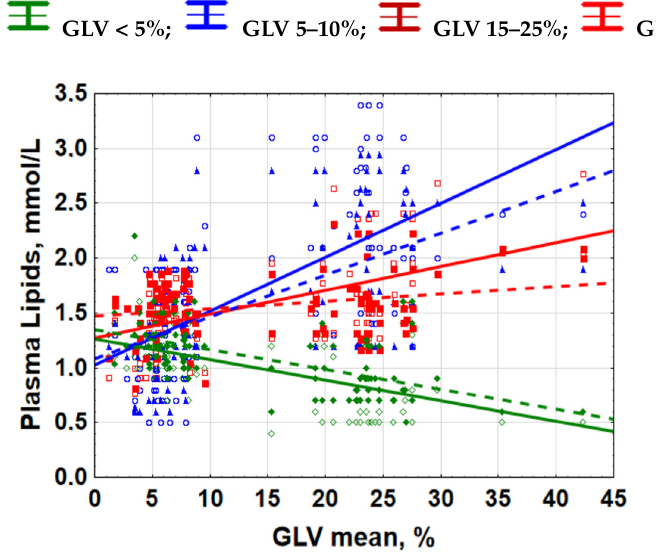
LDL-C MEGs increased further for RGC damage above 25%, Figure 4.